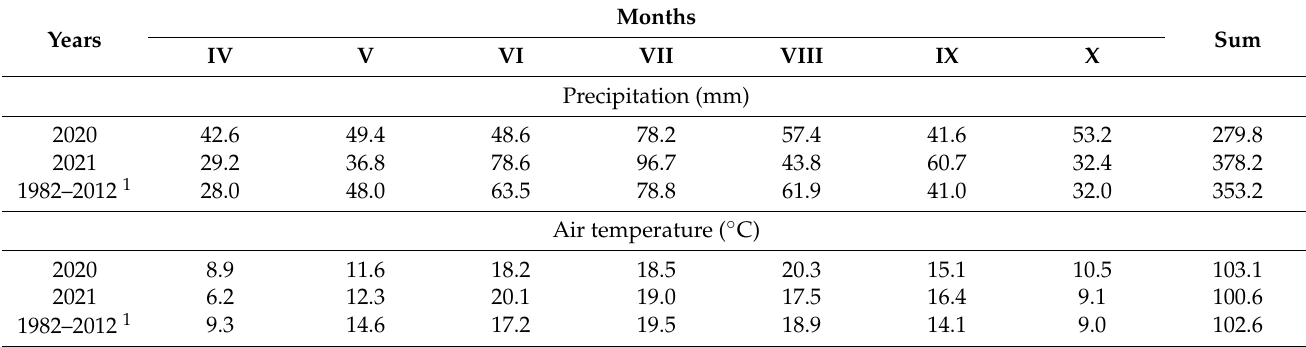
Table 1. The course of climatic conditions in the years 2020 and